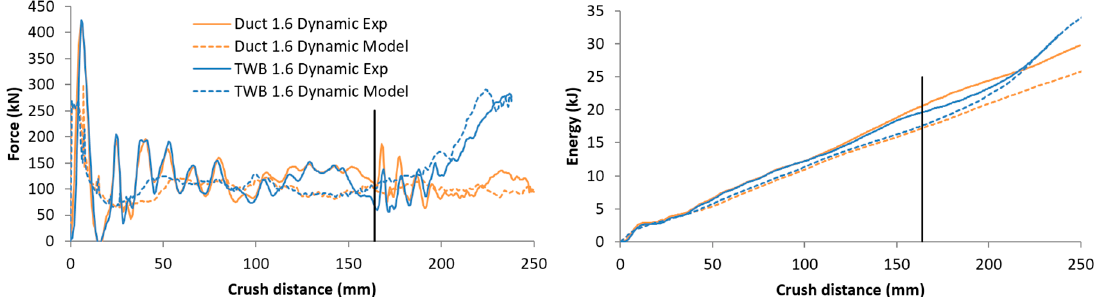
Figure 6. Comparison of dynamic experiments to numerical